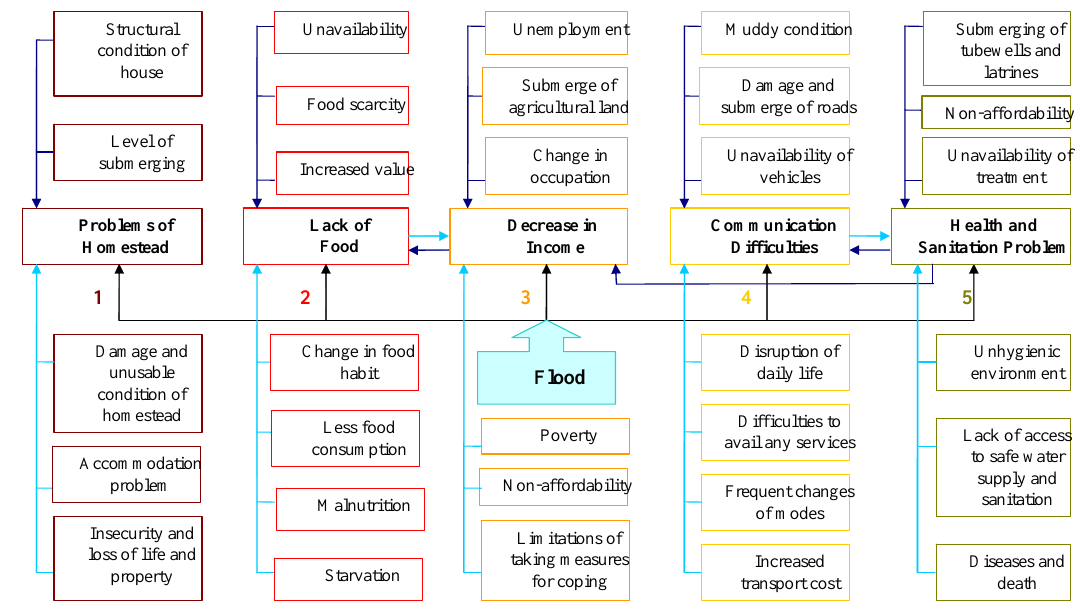
Figure 2. Shifting of occupation due to flood. Source: field survey.